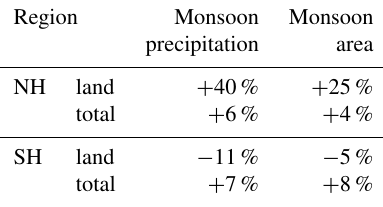
Table 3. Simulated change in northern hemispheric (NH) and southern hemispheric (SH) monsoon area and monsoon precipita- tion for the mid-Holocene (8ka) compared to the late Holocene (2.15ka). The changes have been calculated following the method of Zhou et al. (2008) with the modifications of Liu et al. (2009). Region Monsoon Monsoon precipitation